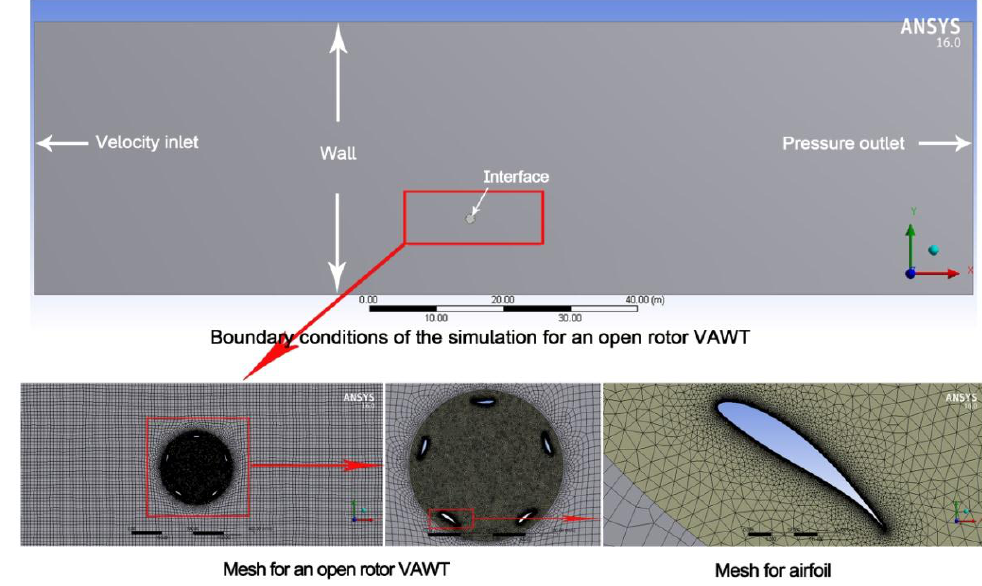
Figure 17. Geometry, boundary conditions and mesh used for the simulation model (open rotor VAWT). Table 3. Three different mesh numbers and the corresponding simulation time.